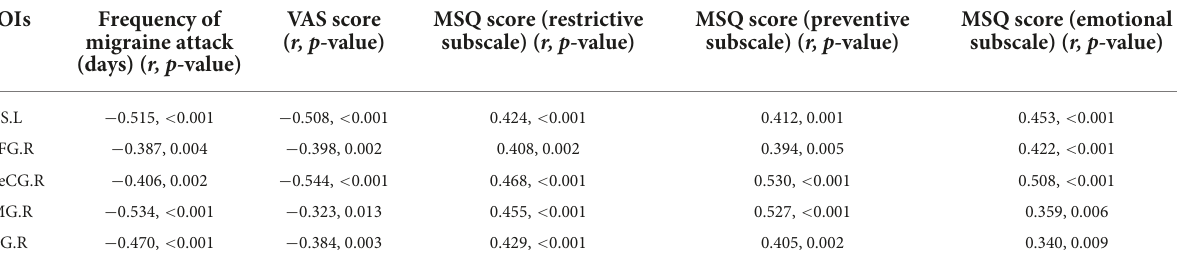
TABLE 5 Correlation between the values of the dynamic GCA coefficient between MFG.R, INS.L, PreCG.R, SMG.R, and FFG.R with RVM and clinical variables after all acupuncture